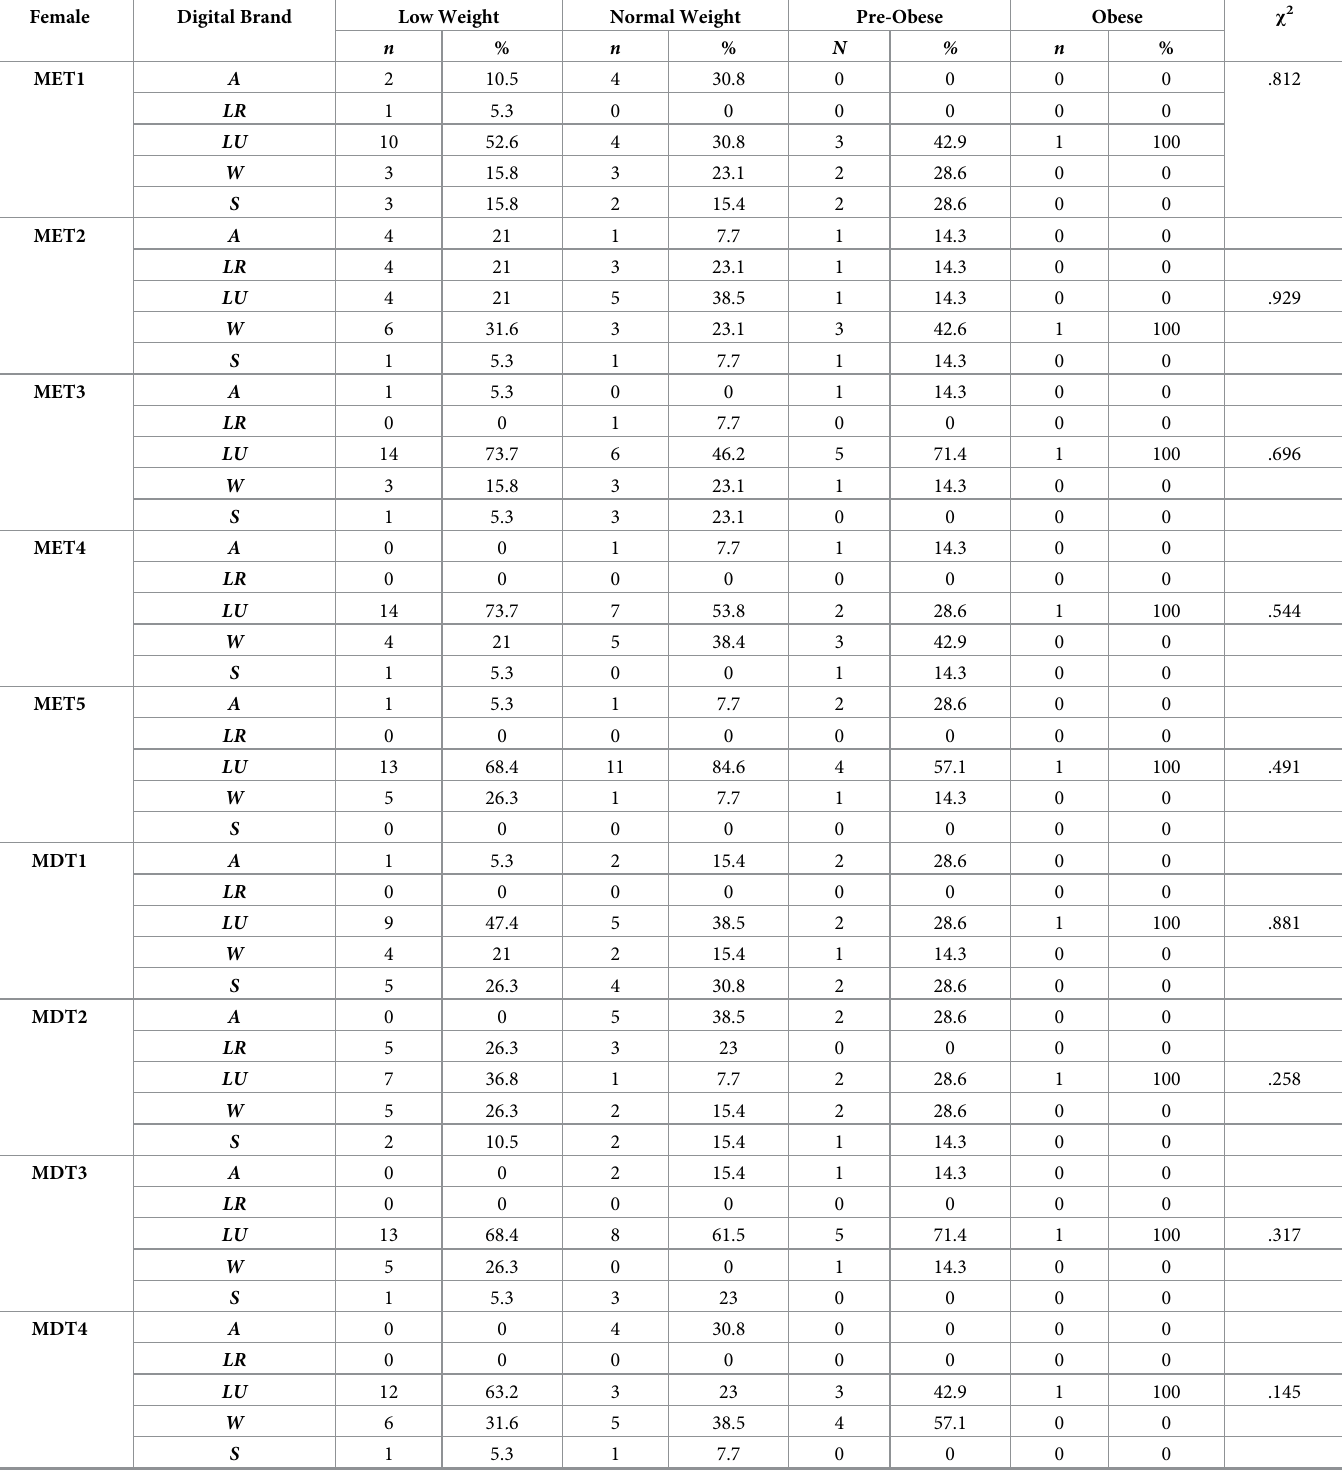
Table 5. Relationship between BMI child and digital types.